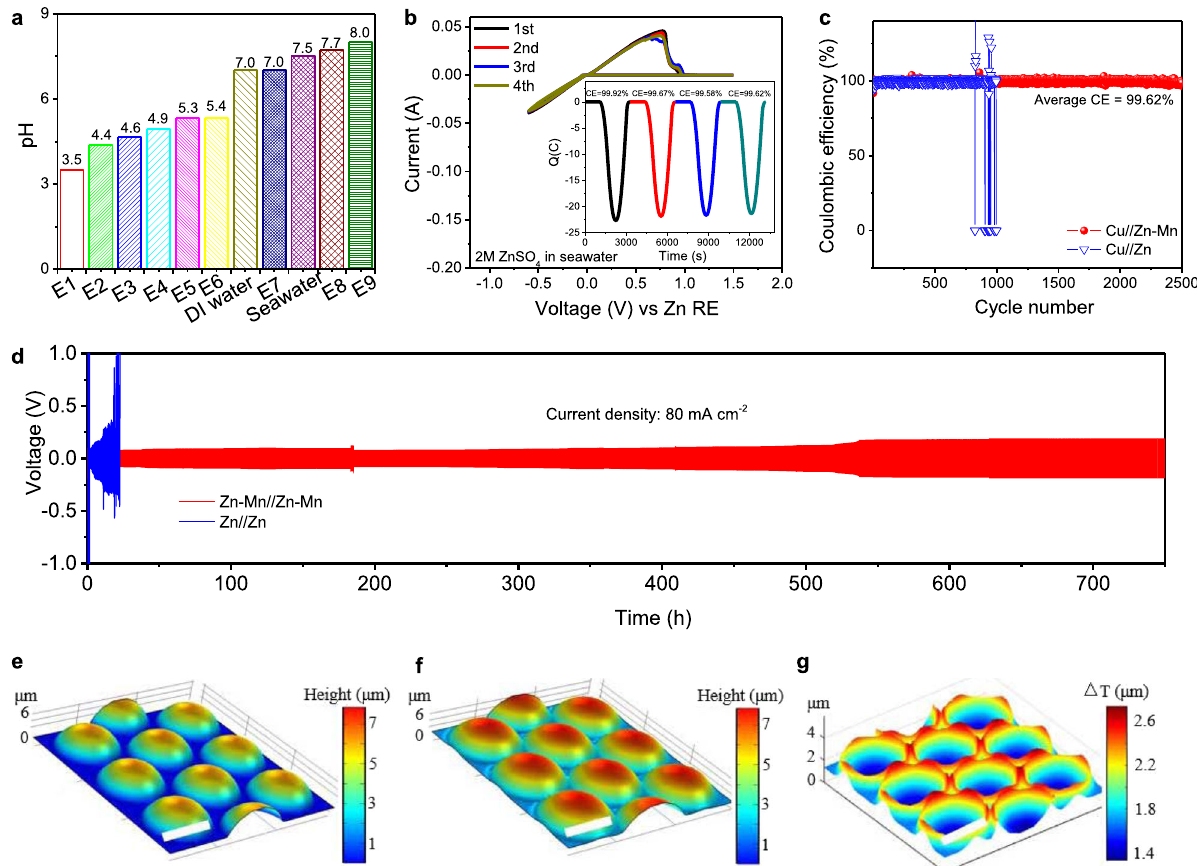
Fig. 2 Electrochemical performance and Zn plating/stripping behaviors of Zn-Mn alloy in the aqueous electrolytes. a pH values of different electrolytes prepared using DI water and seawater as solvents. b Cyclic voltammetry curves of seawater-based electrolytes. Scan rate: 1 mV s − 1 . Working electrode: Pt. Reference and counter electrodes: Zn-Mn alloy. c Long-term galvanostatic cycling performance of Cu//Zn and Cu//Zn-Mn cells at a current density of 10 mA cm − 2 . d Long-term galvanostatic cycling performance of symmetric Zn-Mn and pristine Zn cells at a current density of 80 mA cm − 2 (areal capacity: 16 mAh cm − 2 ; Electrolyte: 2 M ZnSO 4 in seawater). 3D COMSOL simulation: e Morphology of 3D Zn-Mn alloy in 3D COMSOL model before Zn plating. f Morphology of 3D Zn-Mn alloy after 50 s of Zn plating. g Thickness change after 50 s of Zn plating on the Zn-Mn alloy surface. Scale bars in e – g : 20 µ